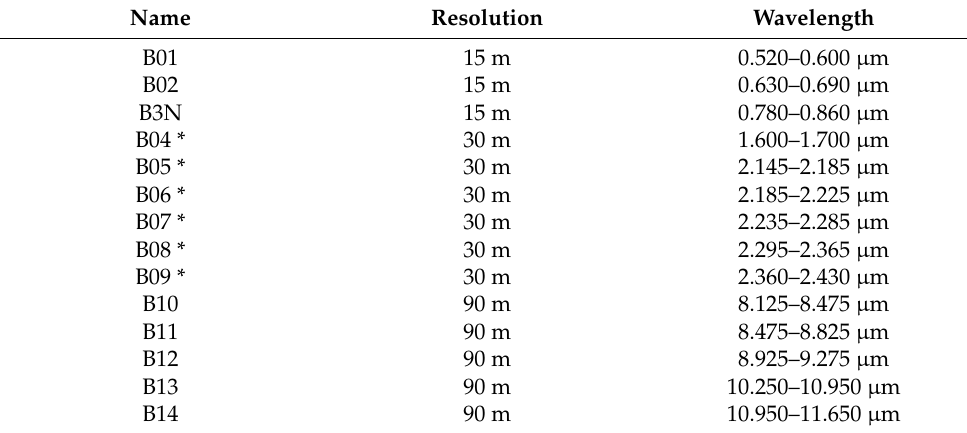
Table 1. Spatial and spectral resolutions of the ASTER